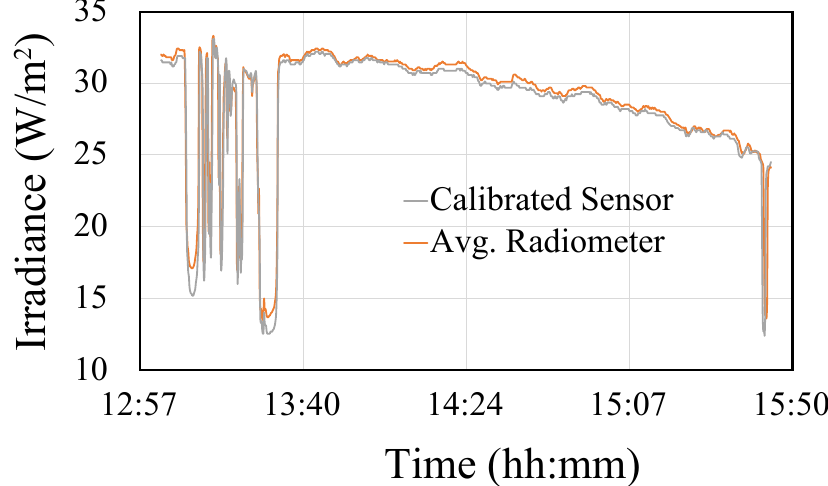
Figure 6. Comparative between the calibrated values of the sensor and the reference pattern provided by the